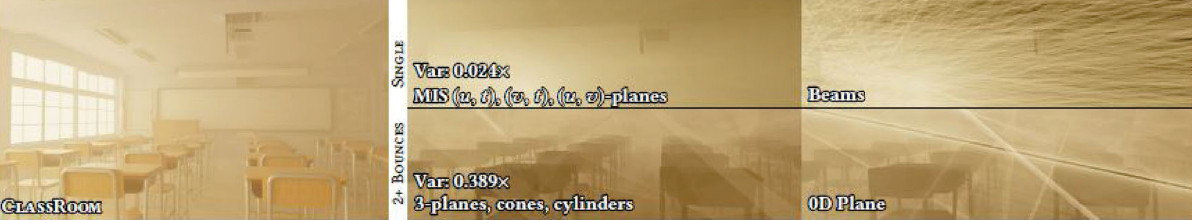
Fig. 5 Equal-time variance of different estimators in a scene containing participating media. Left: full light transport in the scene. Middle/right, above: single scattering. Middle/right, below: multiple scattering volumetric transport. The estimators in the middle provide significant variance reduction compared to prior density estimators on the right for equal rendering time. Reproduced with permission from Ref. [12], c (cid:2) ACM